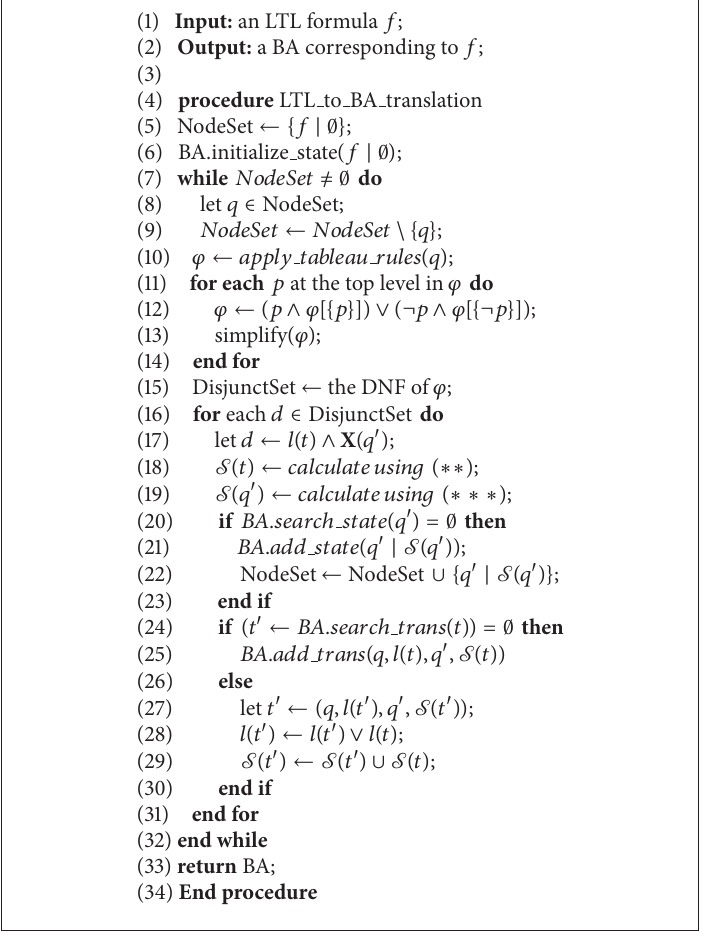
Algorithm 3: The main algorithm of